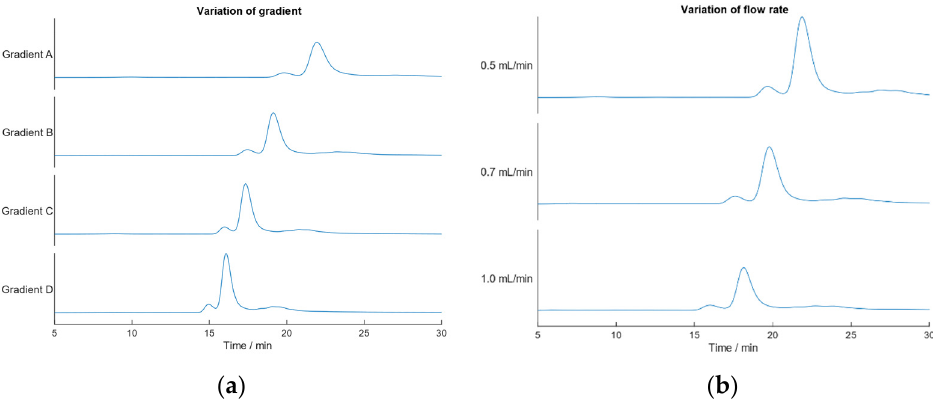
Figure 4. Evaluation of the robustness of the developed IEC-MALS method. ( a ) variation of the linear salt gradient. Gradient A: 0–35% buffer E, gradient B: 0–45% buffer E, gradient C: 0–55% buffer E and gradient D: 0–65% buffer E; ( b ) variation of the flow rate. Flow rates of 0.5 mL min − 1 , 0.7 mL min − 1 and 1.0 mL min − 1 were tested using a linear salt gradient from 0–35% buffer E.